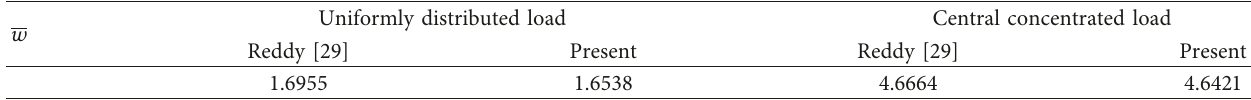
Table 2: Comparison of the nondimensional deflection of a square SSSS composite plate subject to uniformly distributed load and central concentrated load.